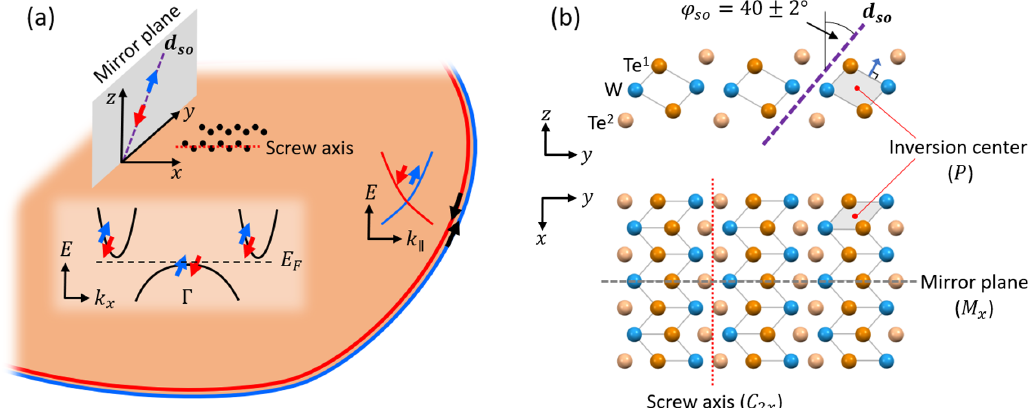
FIG. 1. The spin axis of monolayer WTe 2 . (a) Cartoon illustrating our key findings: The edge modes on monolayer WTe 2 are spin polarized along an axis d that is independent of edge orientation and shared with the bulk conduction and valence band edges, sketched so here schematically near Γ . (b) Side and top views of the 1 T 0 monolayer structure indicating the three spatial symmetries ( P , M , which is in the y - z mirror plane making angle φ and showing the direction of d so shown in blue, and the two inequivalent tellurium atoms, Te 1 and Te 2 , are different shades of orange. The screw axis (red dotted line) is along the center of a zigzag tungsten